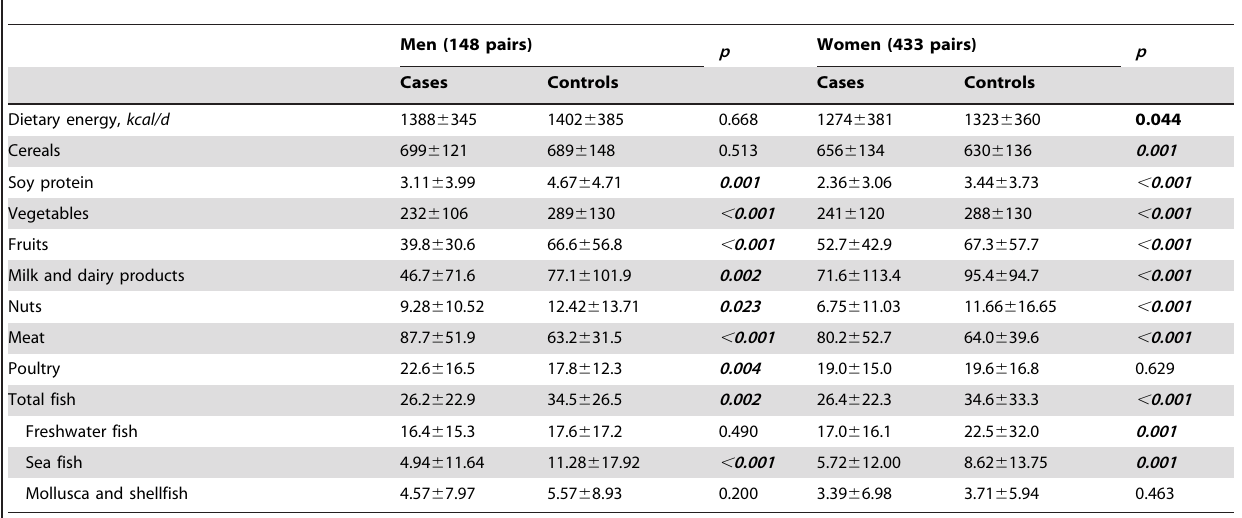
Table 3. Intake of main food groups for study population in Guangzhou, China a .